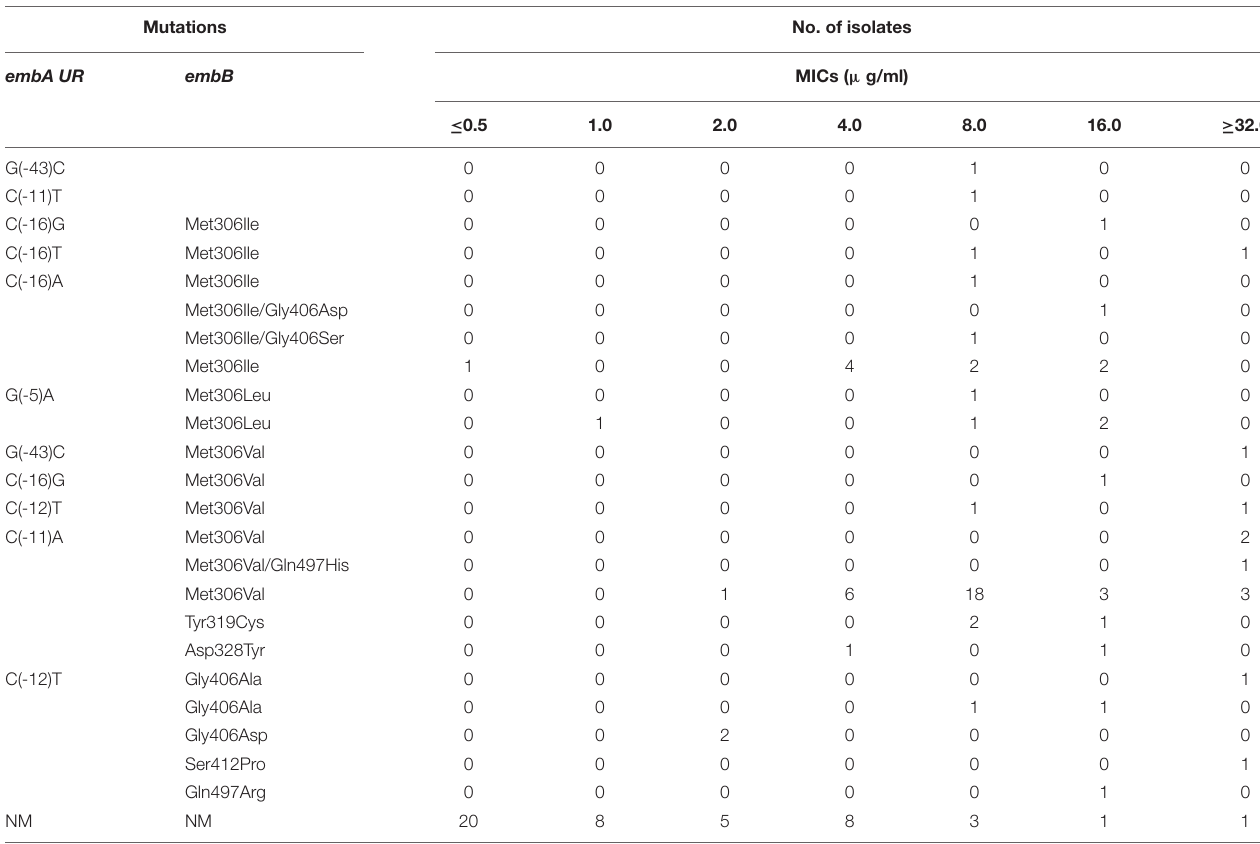
TABLE 3 | Mutations in embCAB among 118 M. tuberculosis isolates. Mutations No. of isolates